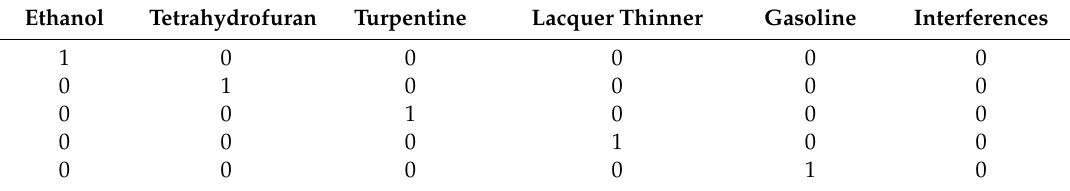
Table 2. The back-propagation artificial neural network (BP-ANN) output layer of the training set. Ethanol Tetrahydrofuran Turpentine Lacquer Thinner Gasoline Interferences 1 0 0 0 0 0